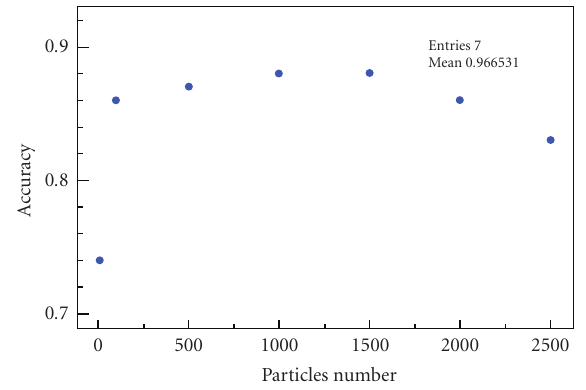
Figure 8: Variation of accuracy depending on the number of particles used in the